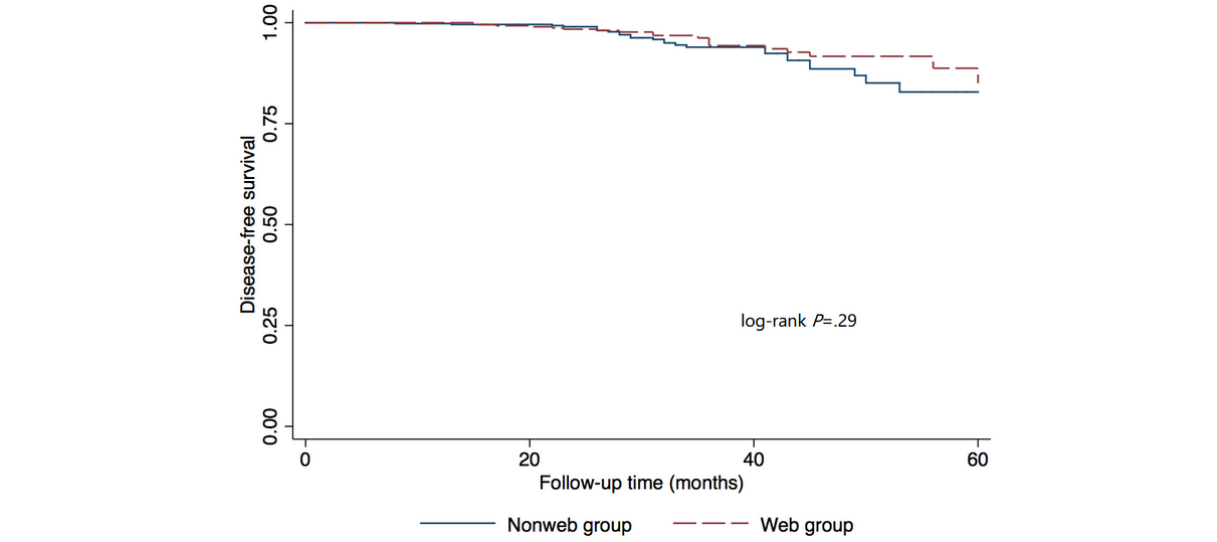
Figure 1. Kaplan-Meier survival curves of disease-free survival by web